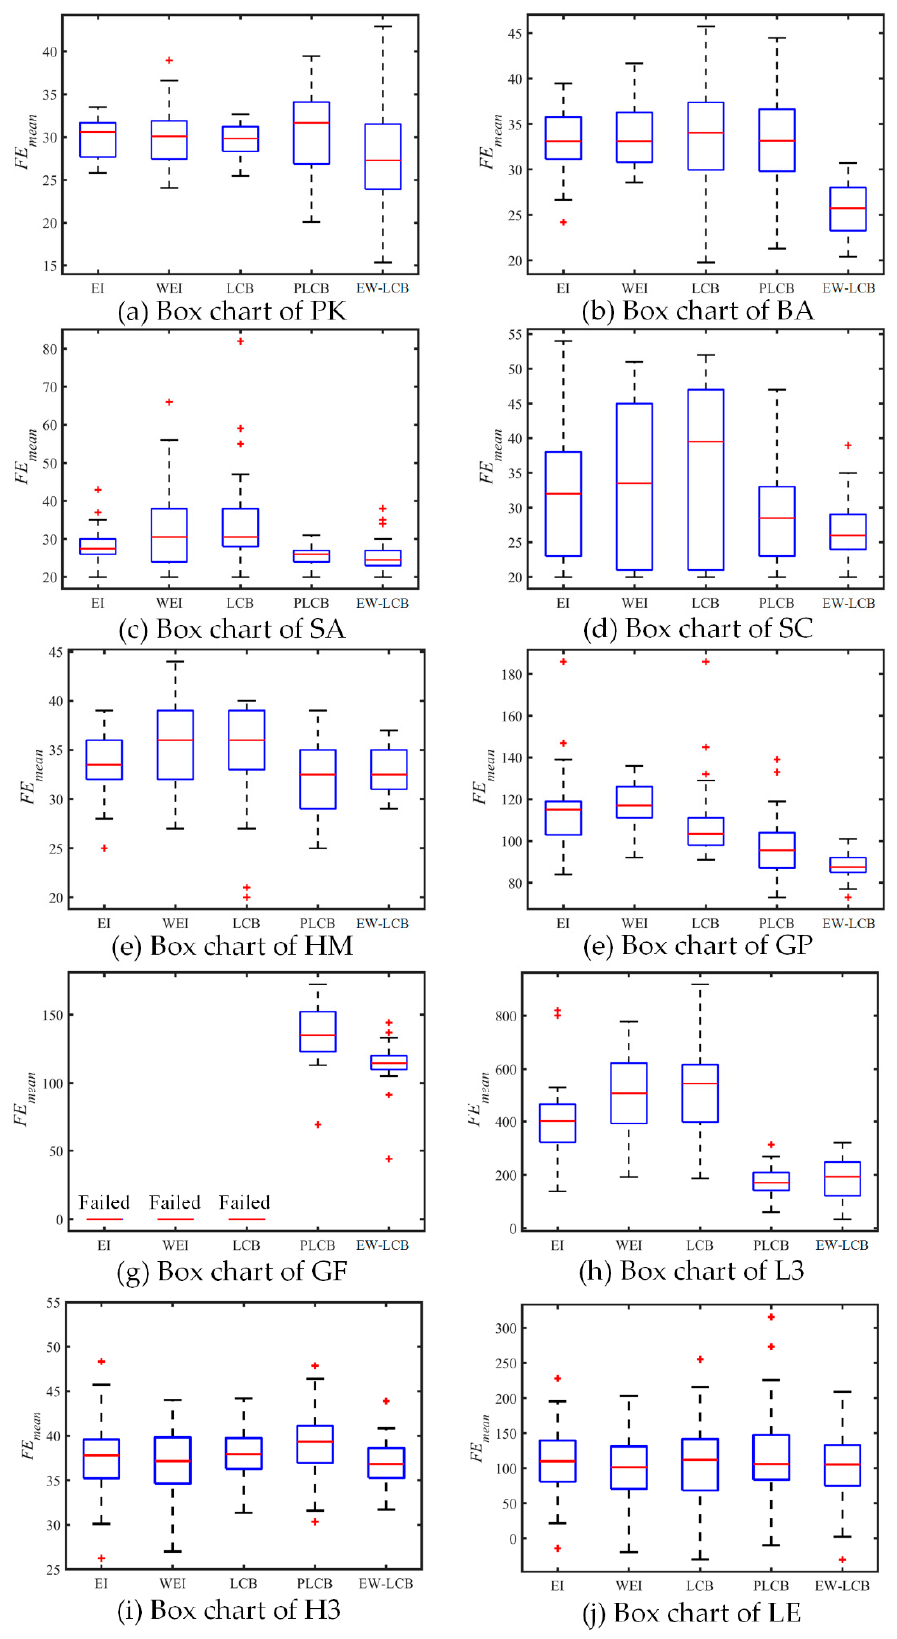
Figure 5. The box plot of the FEmean with different methods.